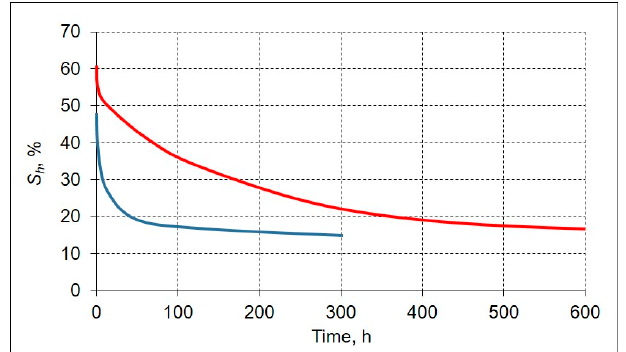
Figure 9. Effect of gas pressure on kinetics of methane hydrate dissociation in frozen fine sand-1 (W in = 17%) at T = − 5.0 to − 5.5 °C. Red and blue lines correspond to pressures of 1.2 MPa and 0.1 MPa, respectively.